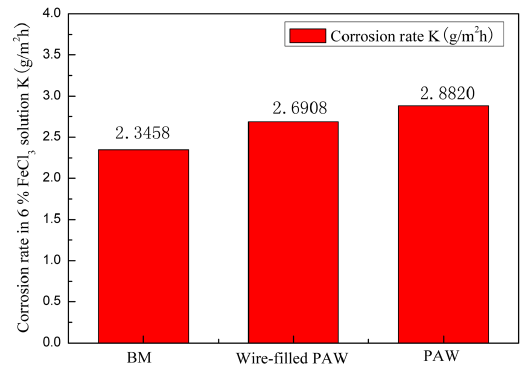
Figure 11. Corrosion rate curves of different